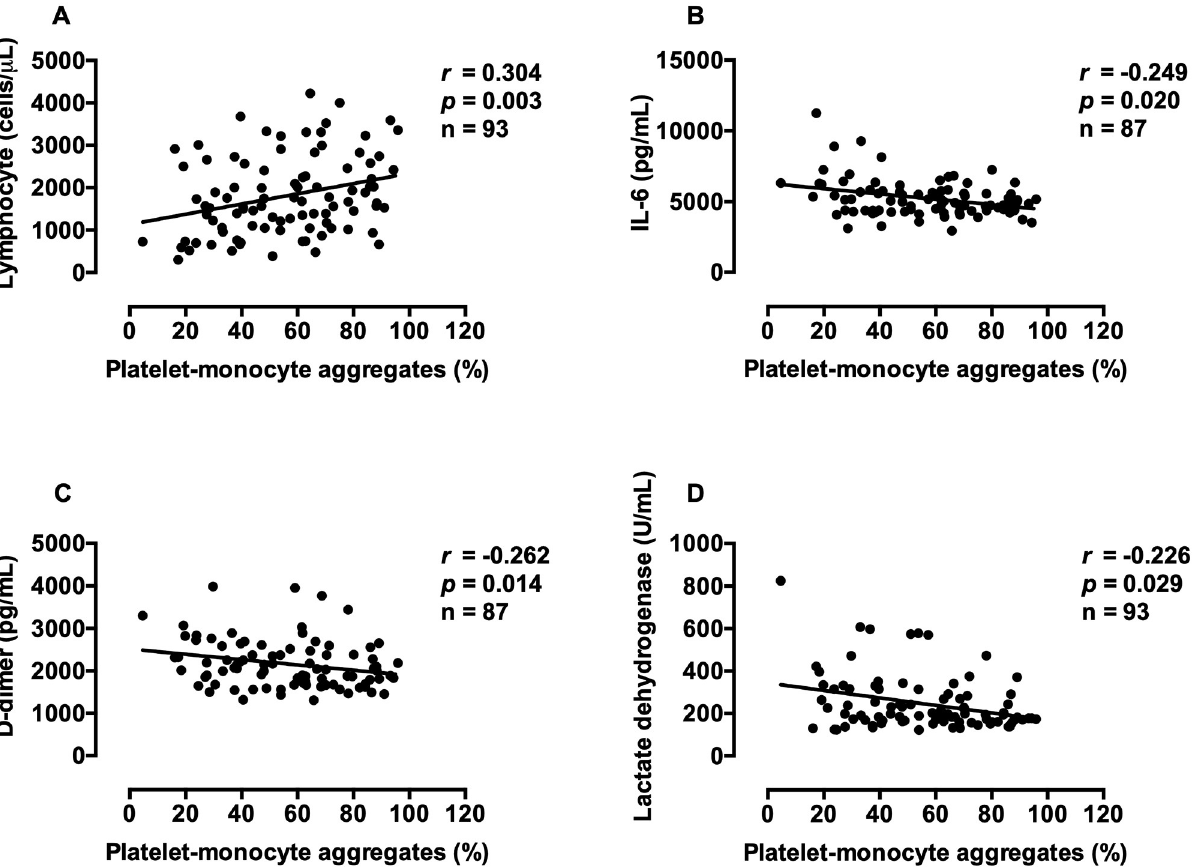
Fig 4. Correlations of platelet-monocyte aggregates with lymphocyte count, interleukin-6, D-dimer, and lactate dehydrogenase were analyzed by Spearman’s rank test.